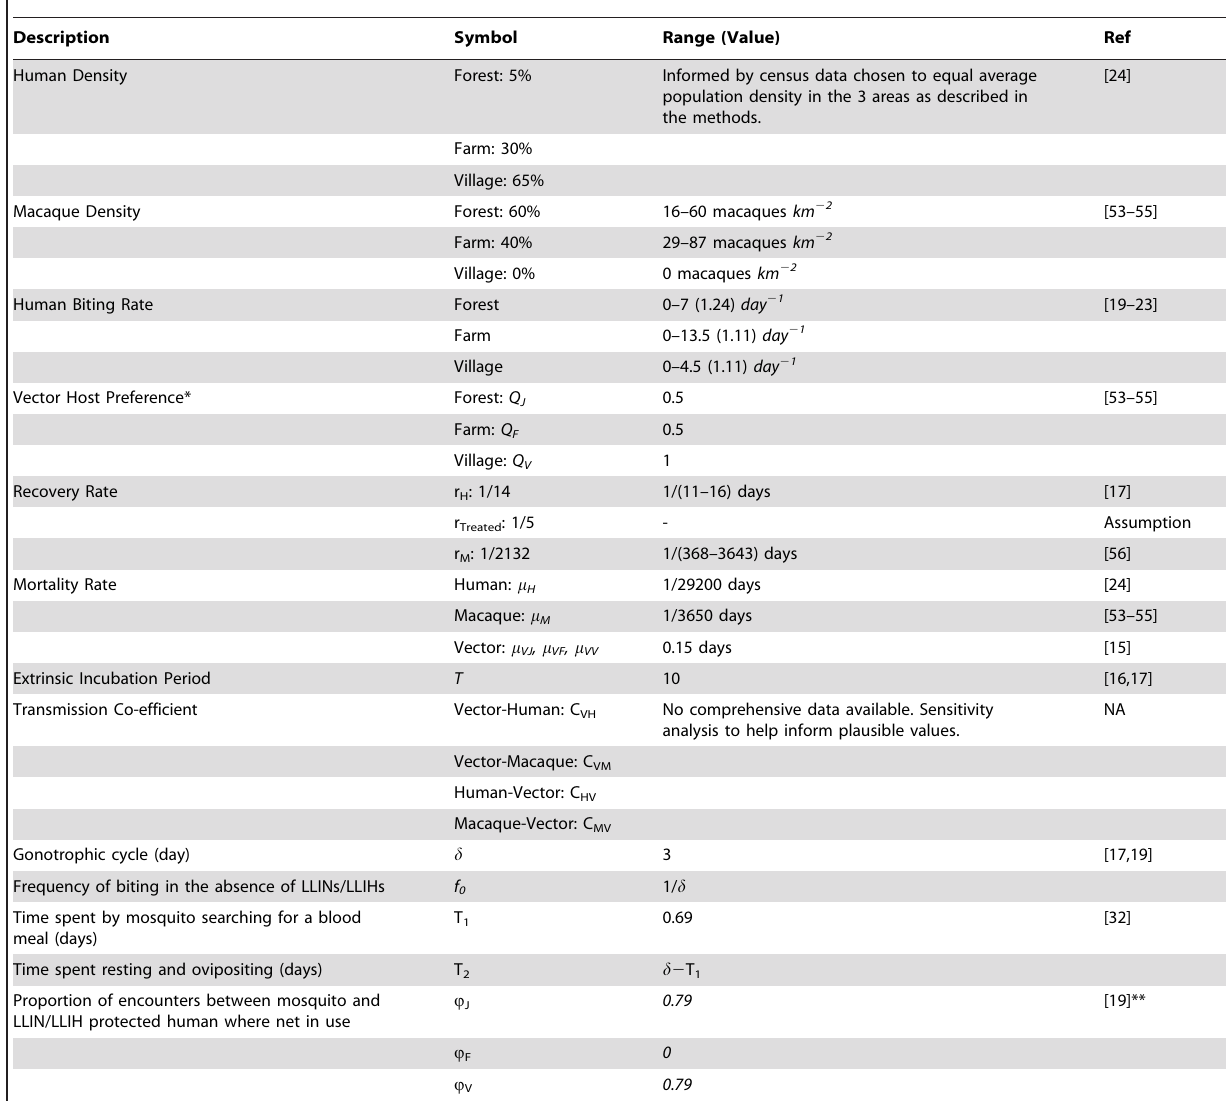
Table 1. Parameters describing interactions between humans, macaques and mosquitoes derived from the literature.